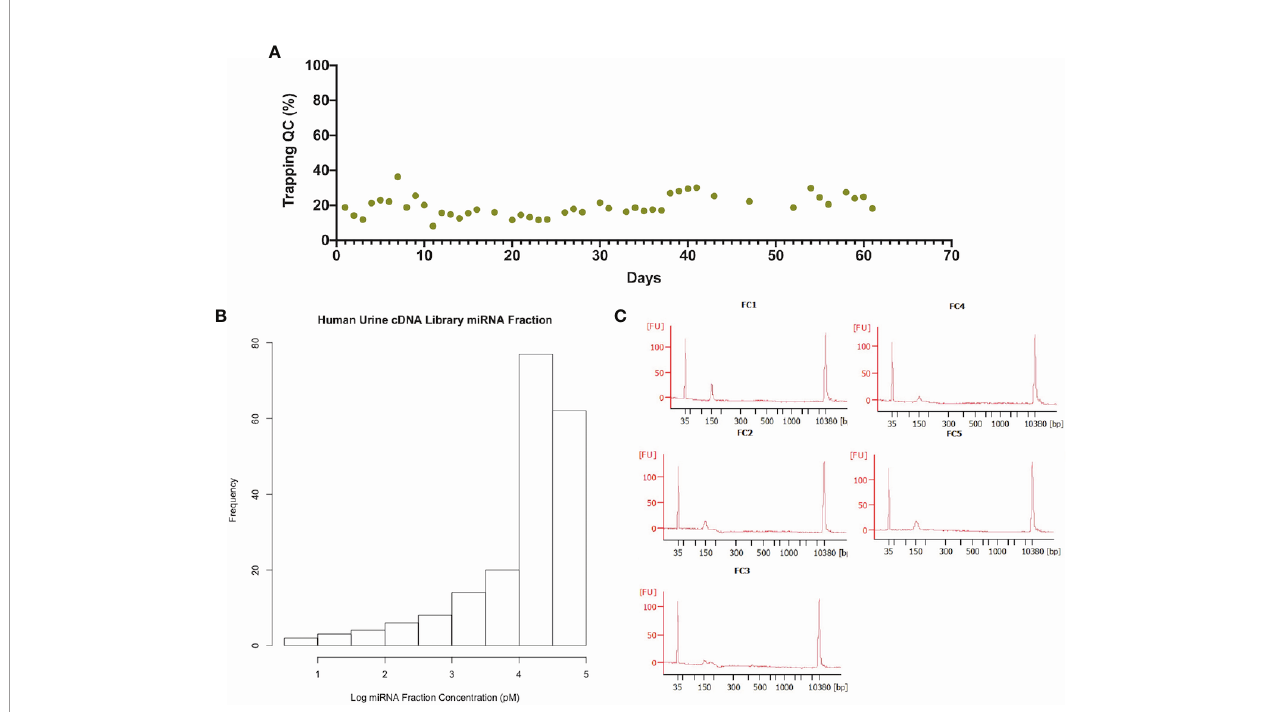
FIGURE 2 | Extracellular vesicle isolation and library preparation. (A) Quality control performed daily on the AcouTrap with 290nm polystyrene beads illustrating the stability of the instrument. The trapping ef fi ciency ’ s mean and standard deviation were 19.7 ± 6% with C.V. of 31%. (B) Histogram of small RNA library concentration between sizes of 140 – 160 nt as quanti fi ed by Bioanlyzer. The median concentration of the samples is 11 nM and an interquartile range of 29 nM. (C) cDNA library pro fi le after sample pooling and size selection. Fluorescent peak around 151 nt corresponding to inserts of approximately 20 nt in length fl anked by 5 ′ and 3 ′ adapters. The fi nal concentrations of the pools, noted as FC1 – FC5, are 0.52, 0.56, 0.21, 0.23, and 0.6 nM between 140 and 160